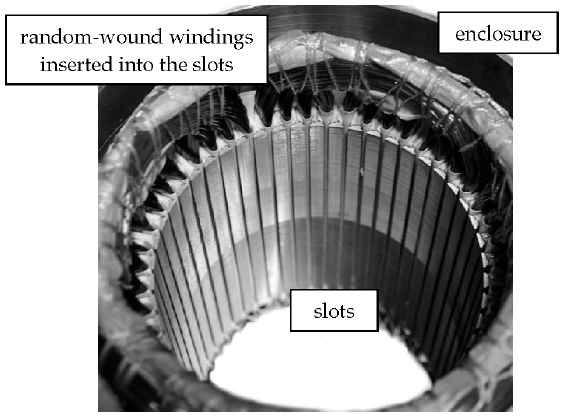
Figure 1. Stator of induction motor with random ‐ wound windings inserted into the slots.